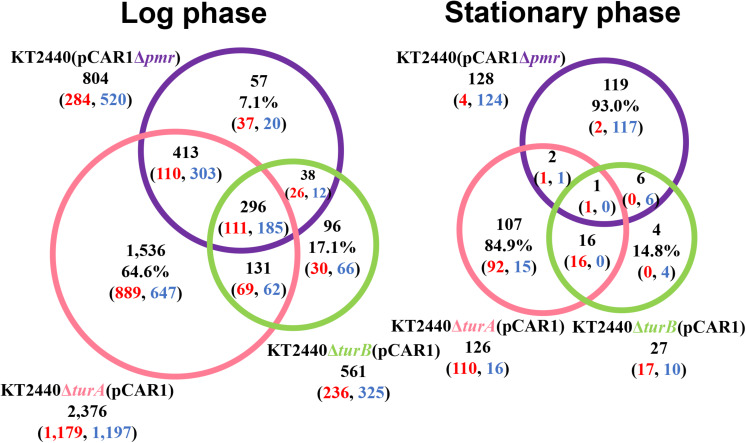
Venn diagram of the differentially transcribed genes in KT2440ΔturA(pCAR1), KT2440ΔturB(pCAR1), and KT2440(pCAR1Δpmr). The numbers of differentially transcribed genes on the chromosome of KT2440ΔturA(pCAR1), KT2440ΔturB(pCAR1), and KT2440(pCAR1Δpmr) compared with the wild-type KT2440(pCAR1) are shown. The numbers of up- and down-regulated genes are shown in red and blue digits, respectively.